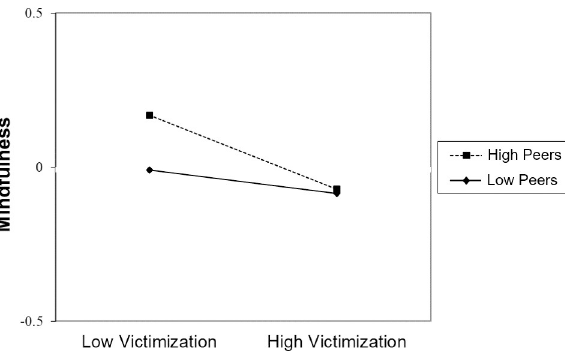
Fig 2. Modeled mindfulness in 7 th grade as a function of victimization and peer belonging in 4 th grade ( N = 4,586). Peers = peer belonging.